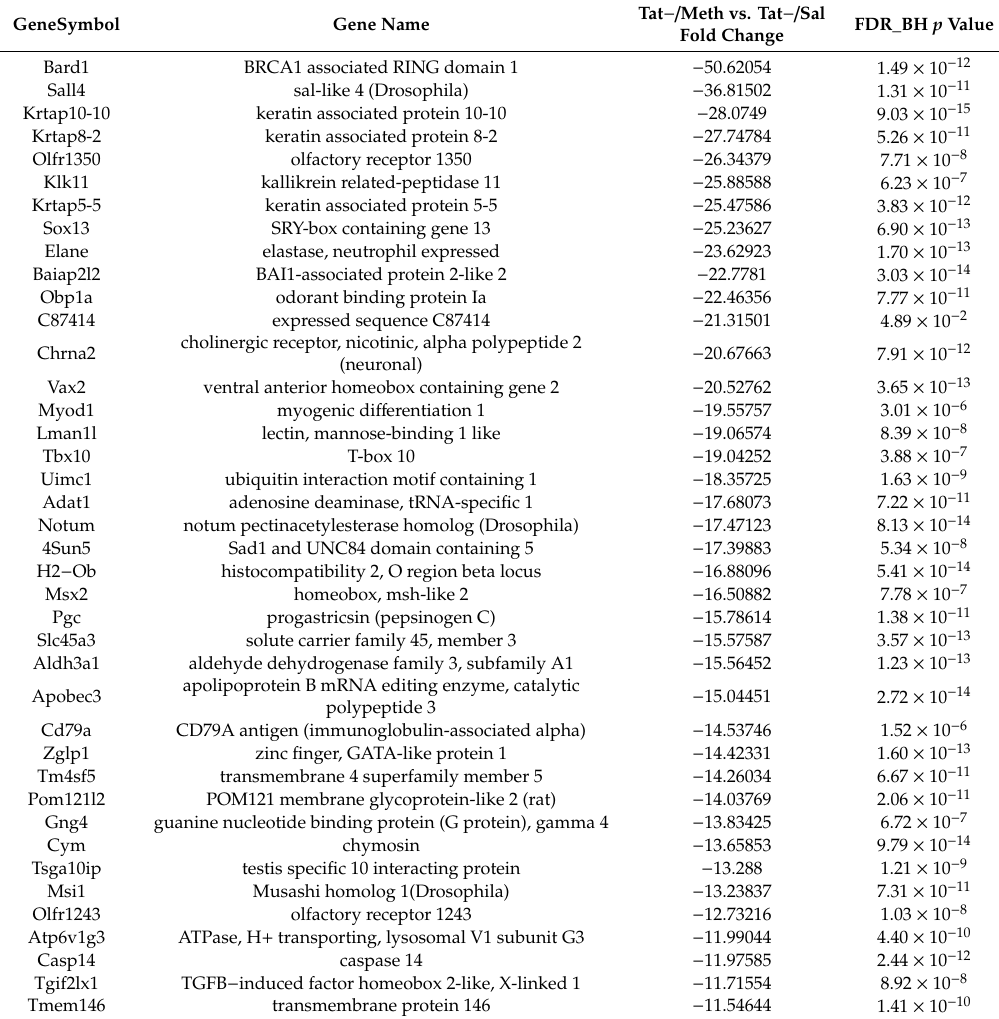
Table 2. Forty most downregulated genes in Tat − / Meth animals as compared with Tat − /